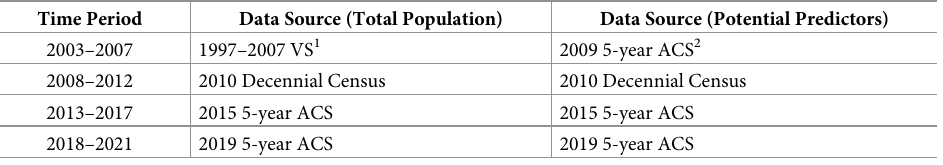
Table 1. Time period-specific data sources for county-level total population and potential predictor variables. Time